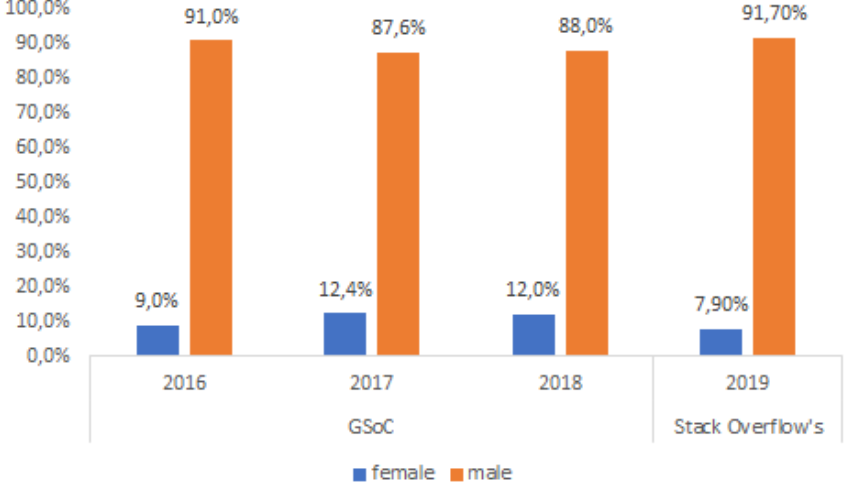
Figure 9. Number of GSoC and Stack Overflow’s participants sorted by gender (adapted from